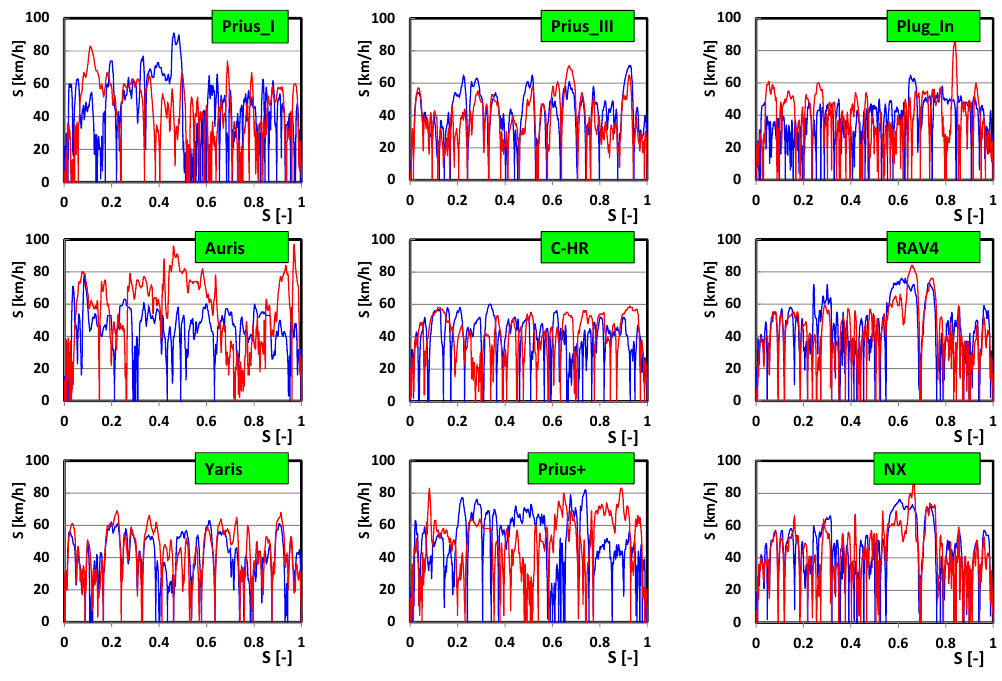
Figure 3. Vehicle speed profiles during the tests (distance as a relative value is shown on the horizontal axis).